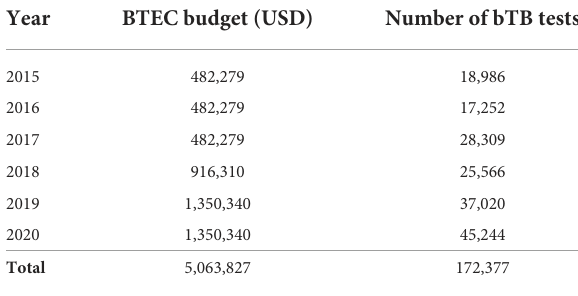
TABLE 1 Budget and number of tests performed by the BTEC program in